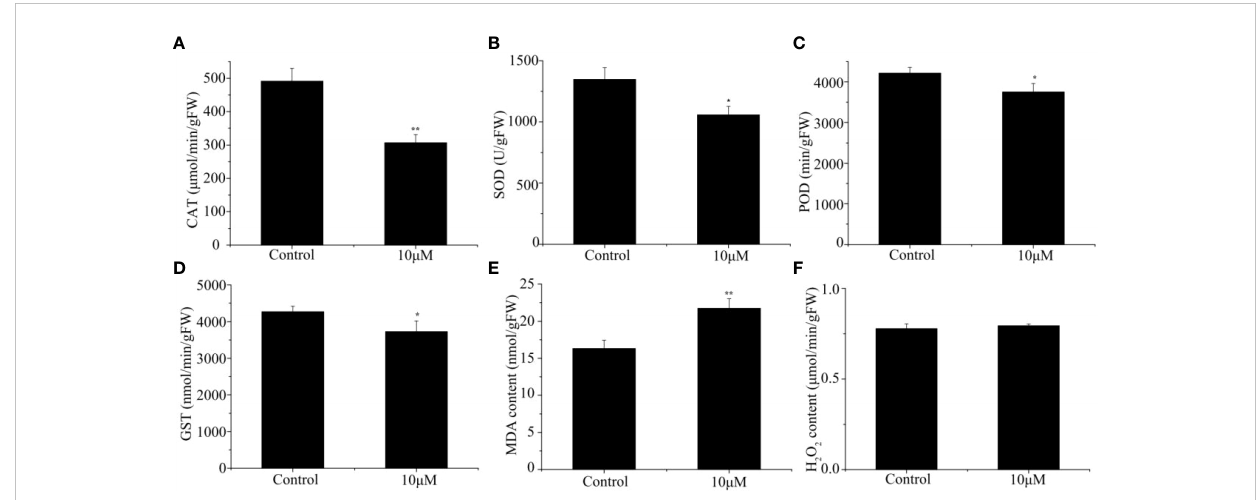
FIGURE 2 Effect of different Cd concentrations on (A) CAT activity, (B) SOD activity, (C) POD activity, (D) GST activity, (E) MDA content and (F) H 2 O 2 content under 0 and 10 m M Cd treatments. Data are means ± SE (n = 3). Asterisks denote signi fi cant differences (* P< 0.05 ; ** P< 0.01 ).